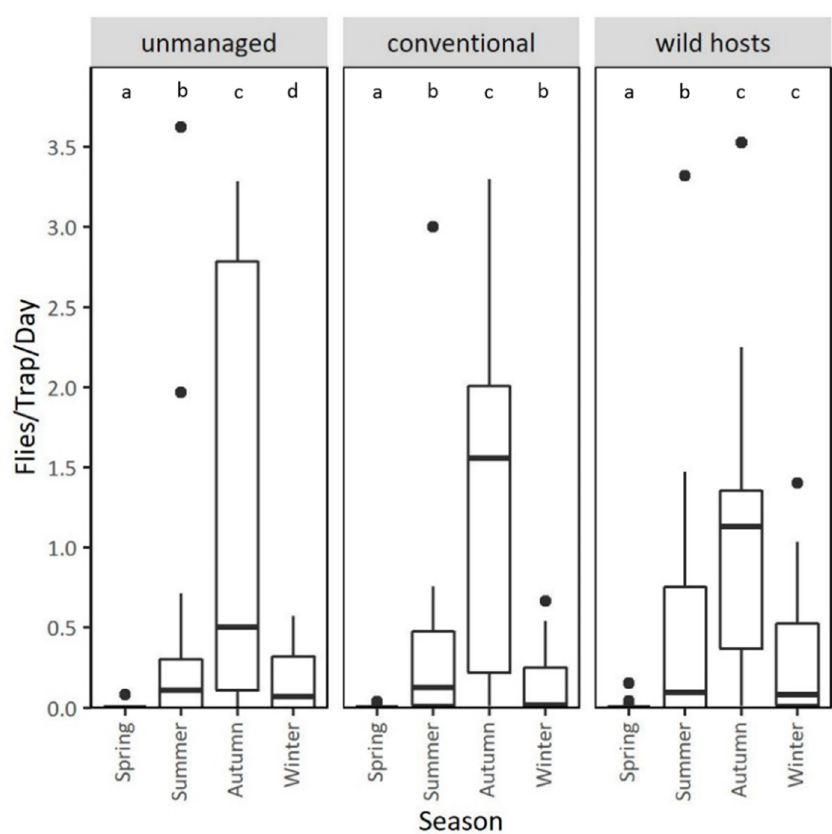
Figure 7. Adult captures in unmanaged and conventionally treated cherry trees, and wild hosts– Rubus sp., of the semi-highland area Agia Fotini, grouped by season. Values within a chart followed by the same letter do not differ significantly ( p > 0.05).